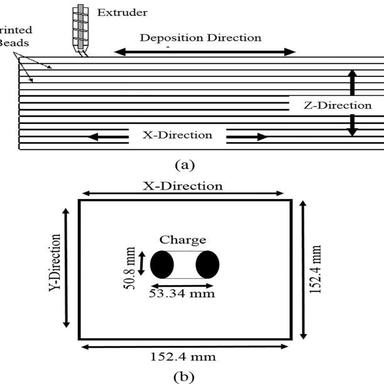
Schematic for testing coupons directions; (a) EDF-AM hexagon edge (304.8 × 304.8 mm²). and (b) ECM plaque (152.4 × 152.4 mm²). Charge Placement: Location of the charge placed in the mold.